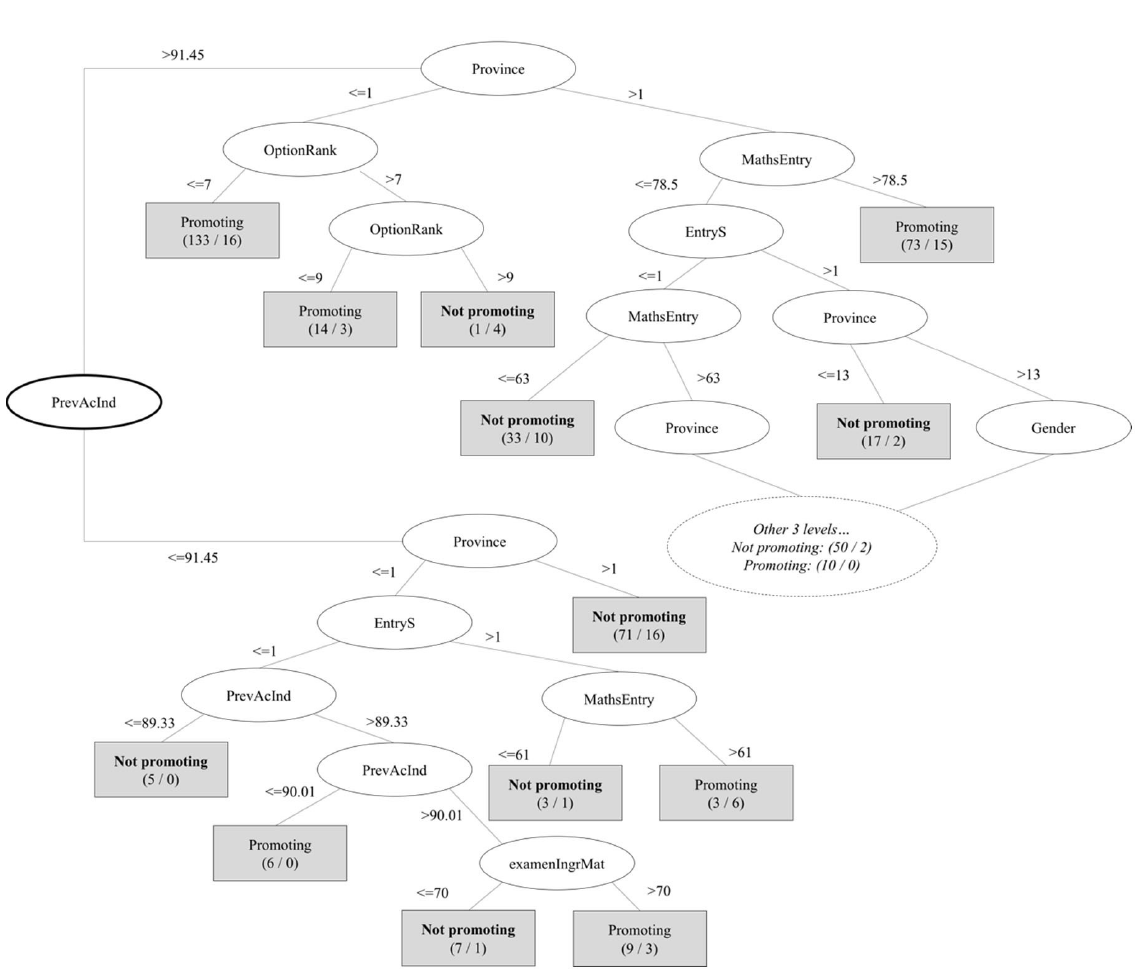
Figure 3. Decision tree corresponding to pre-registration